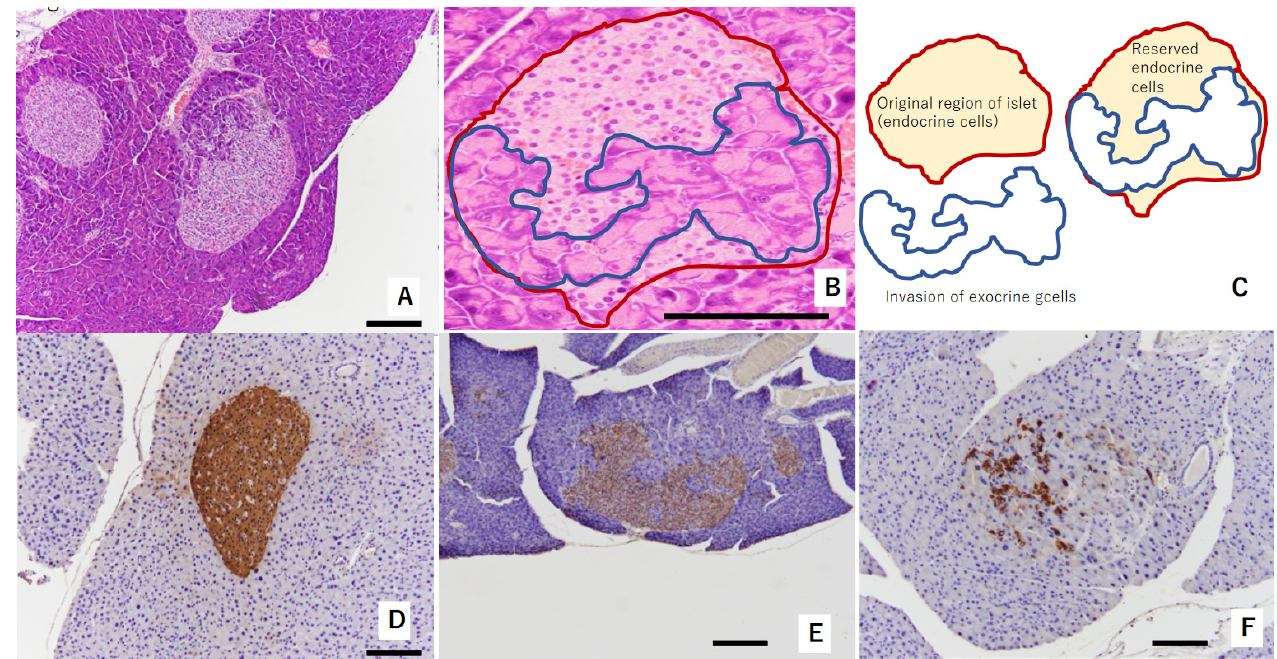
Figure 1. Representative figure showing morphological abnormalities of islets of Langerhans in experiment 1: ( A ), ( B ) exocrine gland extends into swelled islet of Langerhans. Red circle shows original region of islet endocrine cells. The area circled by blue shows invasion of exocrine cells. These areas are shown in ( C ) as a schema. These islets were evaluated as “mild morphological change” (HE staining). ( D ) Swollen islet of Langerhans was constructed by beta-cells with abundant insulin (IHC of insulin). This islet was evaluated as “no change”. ( E ) Exocrine gland extended into swollen islet of Langerhans. Swollen islet of Langerhans was constructed by mixture of beta-cells with weak insulin (IHC of insulin) and exocrine gland. This islet was evaluated as “mild morphological change”. ( F ) Exocrine gland severely extended into swollen islet of Langerhans. Scattered beta-cells (IHC of insulin) were observed within originally swollen islet of Langerhans. This islet was evaluated as “severe morphological change”. Scale bar: 200 μ m.